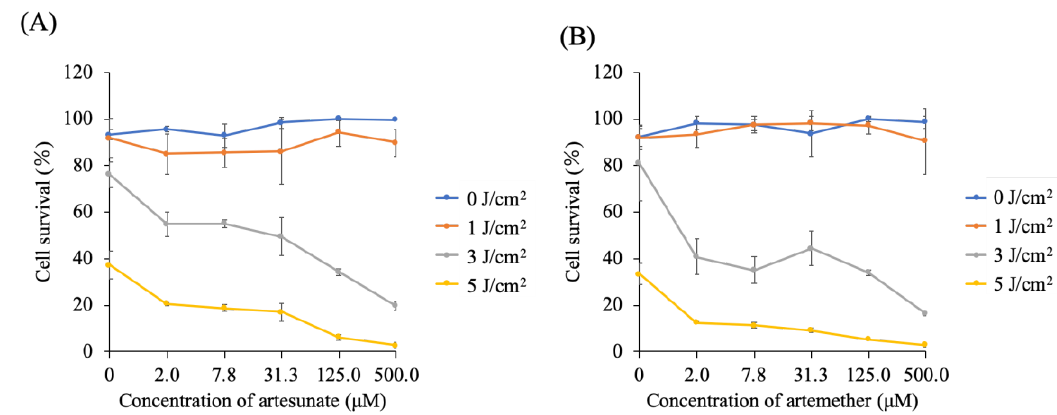
Figure 3. Cytotoxicity analysis of the artesunate (ART) or artemether (ARM) dose. Cells were incubated for 4 h with 1 mM 5-aminolevulinic acid (5-ALA) and various concentrations (0, 2, 7.8, 31.3, 125, and 500 µ M) of ( A ) ART or ( B ) ARM. After washing with fresh medium, cells were irradiated with a 630-nm light (20 mW / cm 2 , 10 J / cm 2 ) emitted by LED lights. At fluorescence intensities of 3 and 5 J / cm 2 , the viability of the 5-ALA-photodynamic therapy (PDT)-treated cells was significantly decreased in the presence of ART ( p < 0.01 and p < 0.01) or ARM ( p < 0.01 and p < 0.01). Results are presented as means ± standard deviations ( n =